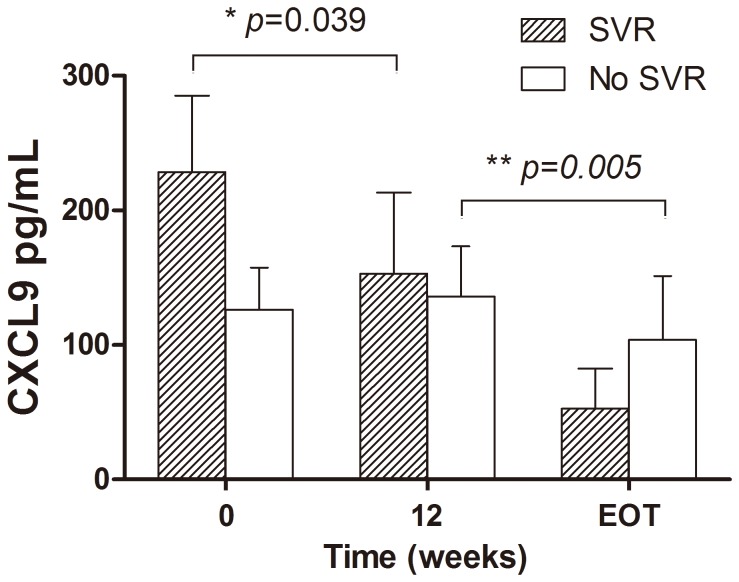
Kinetics of serum CXCL9 levels during PEG-IFN treatment in CHB patients with or without SVR.In patients with SVR, CXCL9 levels significantly decreased from baseline to week 12, whereas in patients without SVR, CXCL9 levels remained high at week 12 but decreased later from week 12 to EOT. Data were presented as mean ± standard errors of the means (SEM). EOT: end of treatment.